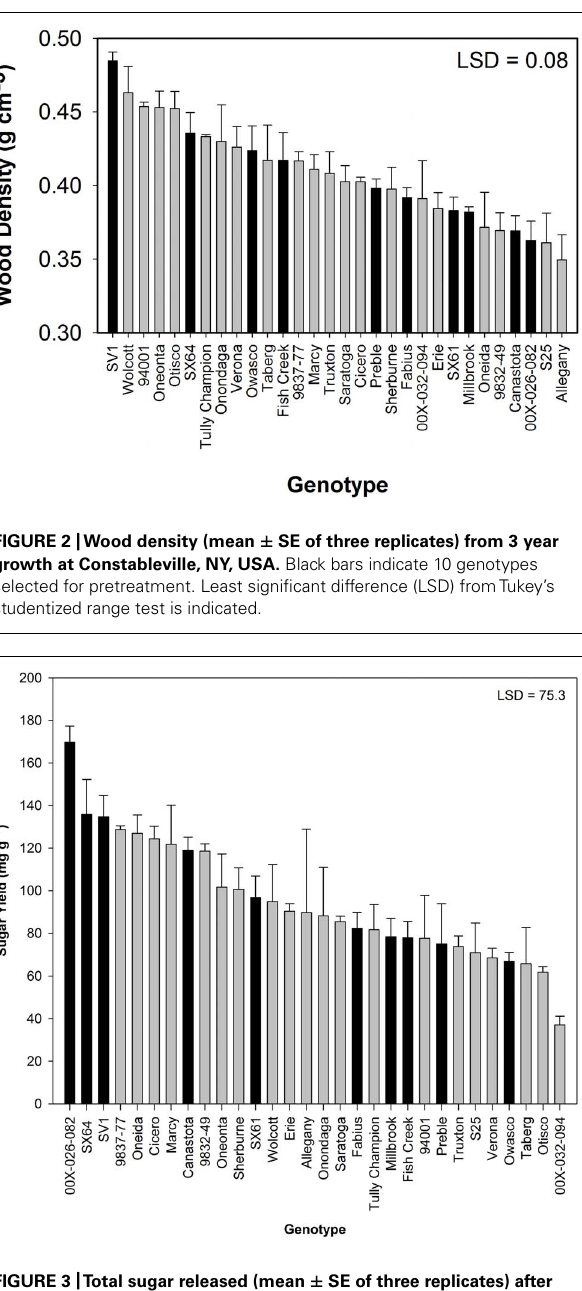
FIGURE 5 | Ethanol yield (mean ± SE of three replicates) from simultaneous saccharification and fermentation after two incubation